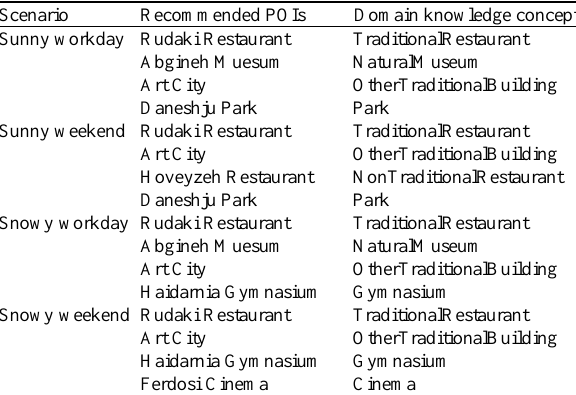
Table 2. The recommended POIs in four